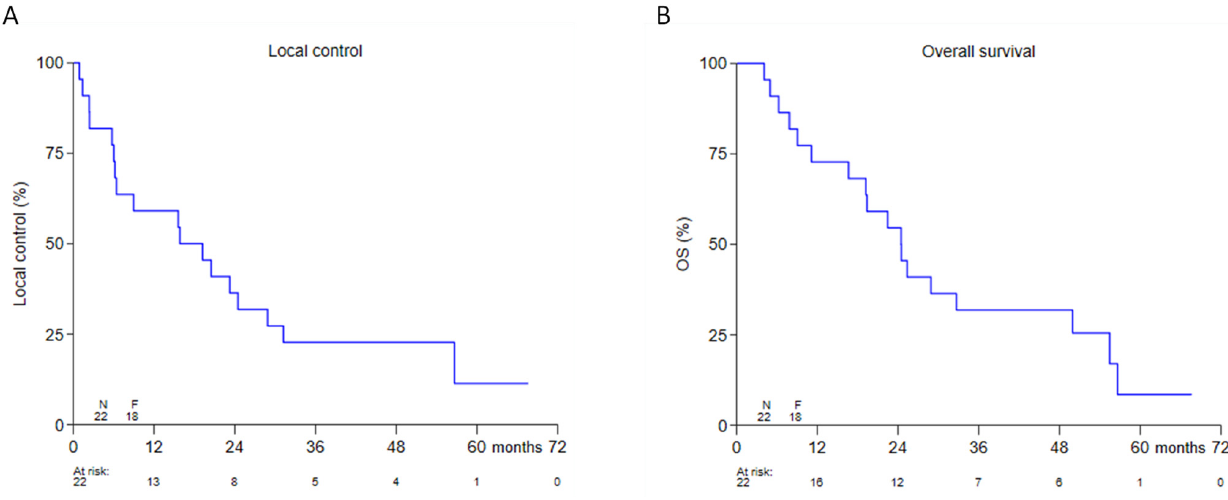
Figure 1. Kaplan-Meier analysis for LC ( A ) and OS ( B ) in 22 patients with a recurrent or second primary head and neck cancer.